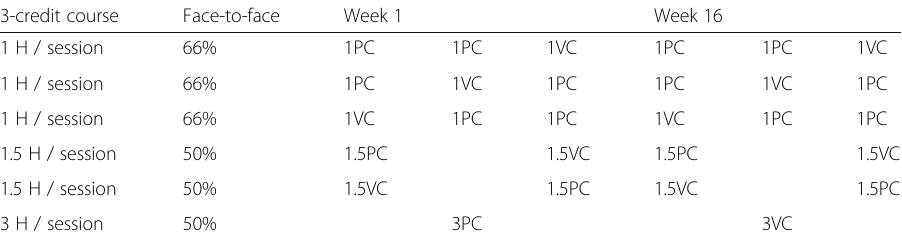
Table 5 Time mix of learning modalities in a 3-credis bLearning course (Source: